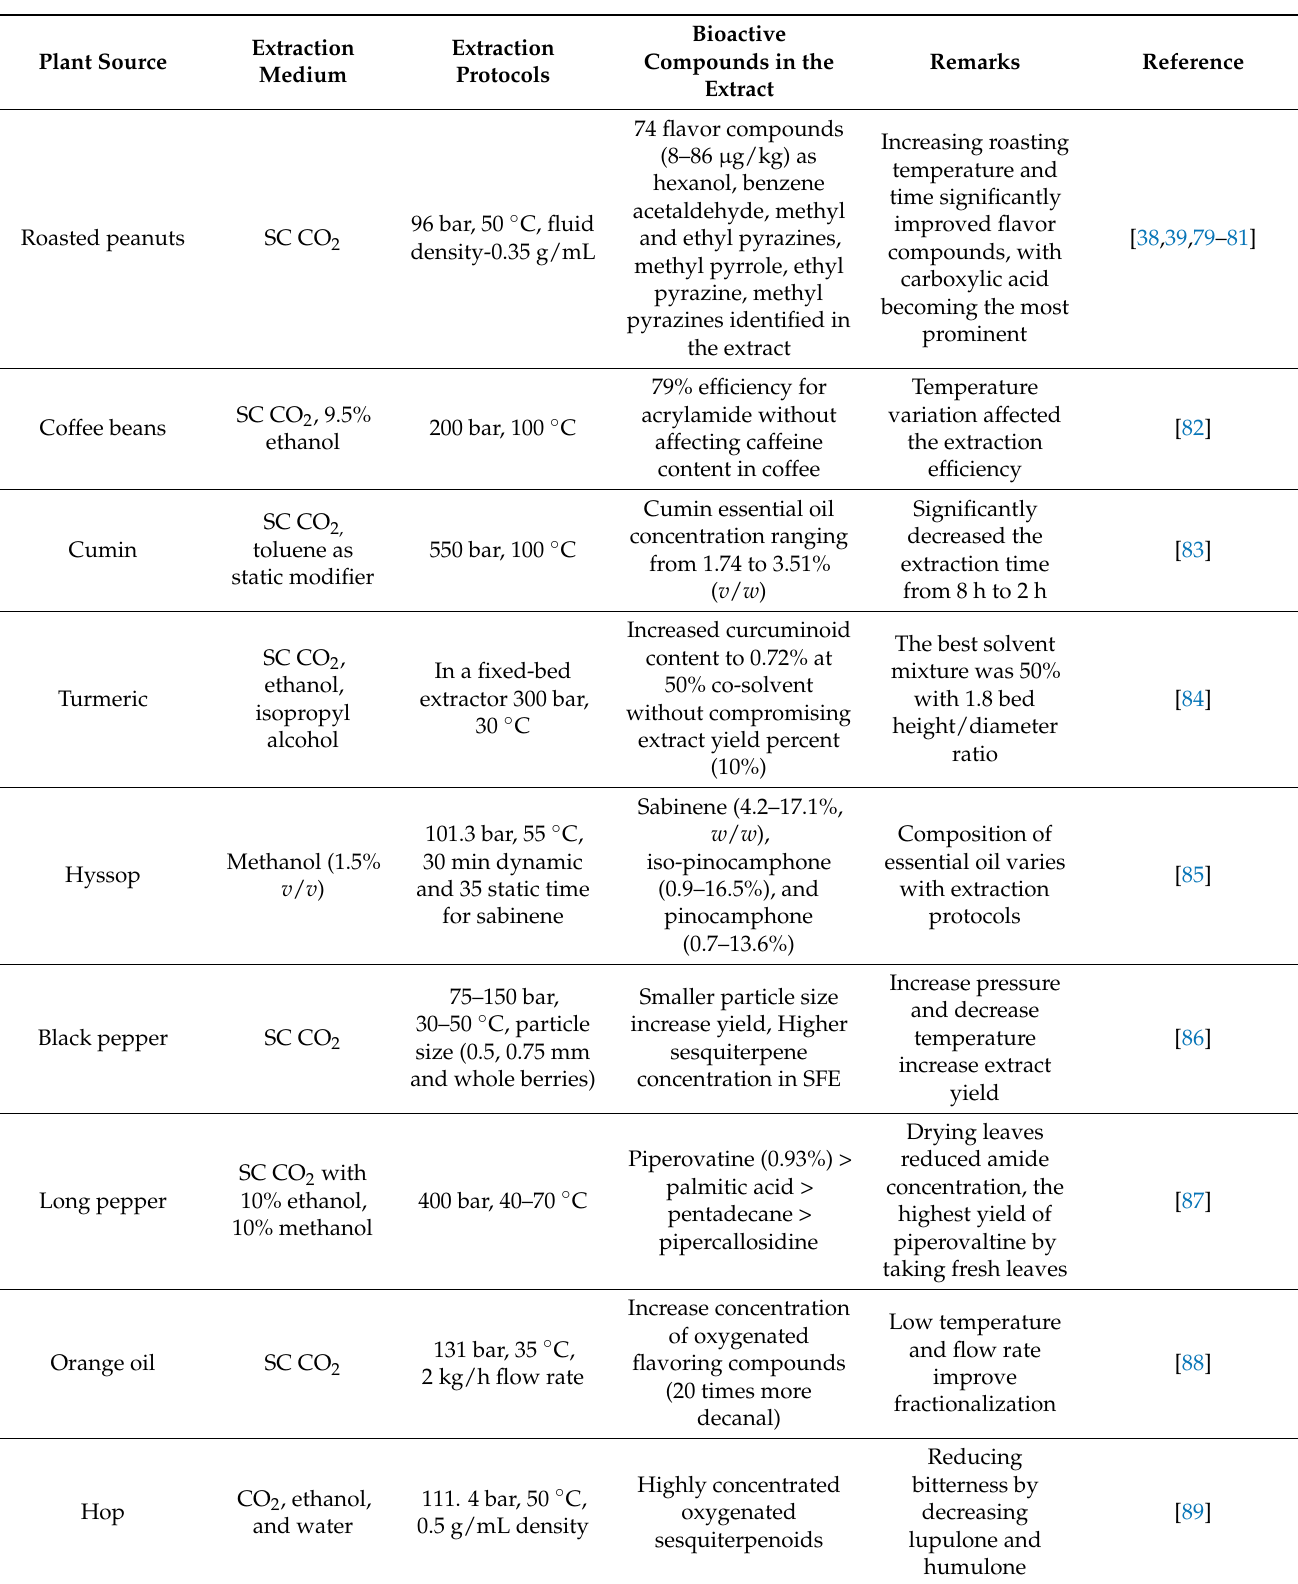
Table 4. Extraction of bioactive compounds from plant biomass by using supercritical